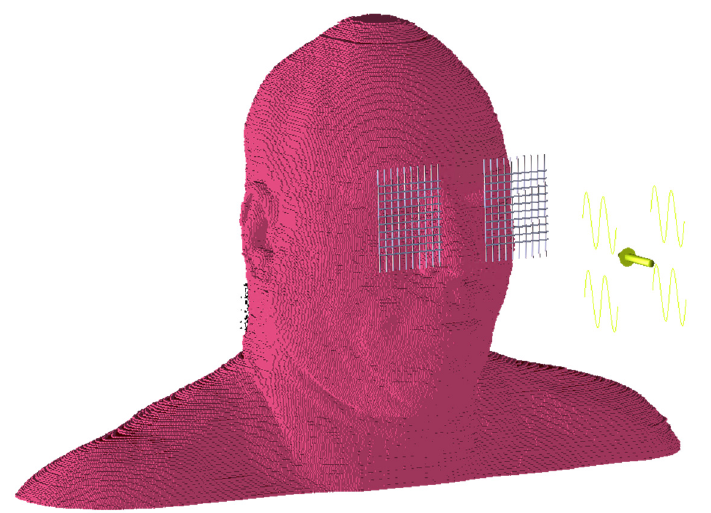
Figure 12. The heterogeneous model with the synthesized shielding structure.